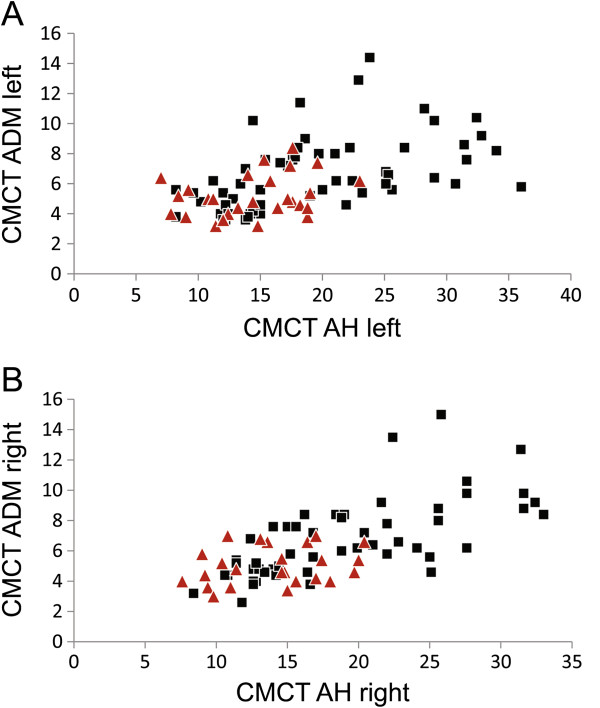
Correlation of central motor conduction time (CMCT) to arm and leg. CMCT to the abductor digiti minimi muscle (ADM) and abductor hallucis muscle (AH) is correlated (r = 0.595; p < 0.0001). In (A) results for the left-hand side, in (B) for the right-hand side are shown. Patients with SPG4 mutations are indicated by red triangles, other patients by black squares.